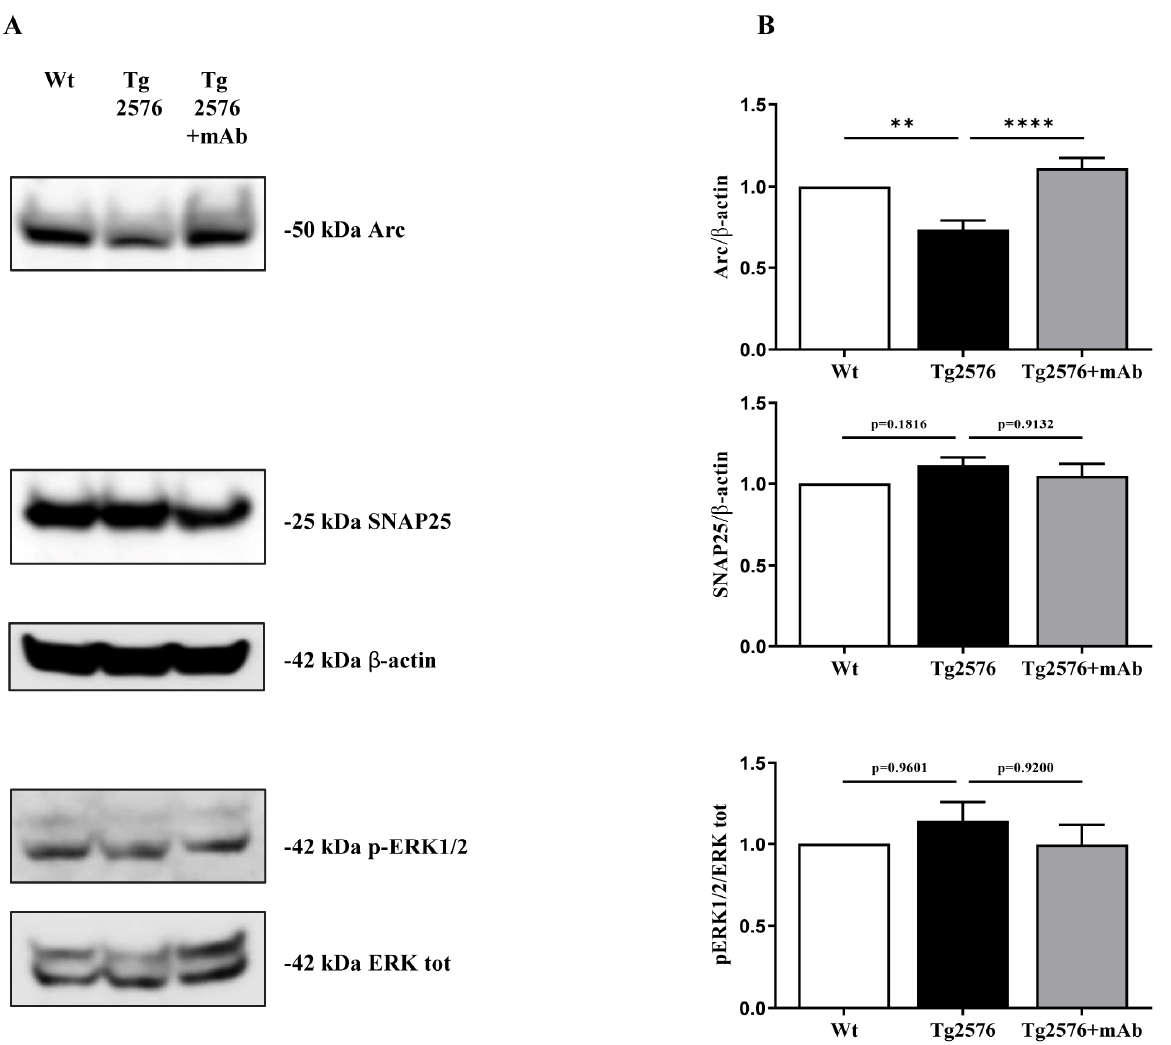
Figure 3. Effect of 12A12mAb immunization on expression pattern of experience − dependent markers of V1 plasticity from Tg2576 AD mice . ( A ) Representative images of SDS-PAGE western blotting analysis (n = 8 animals per each group, 4 males and 4 females for each experimental condition) carried out on protein homogenates of the primary visual cortex (V1) from animals of three experimental groups (littermate wild-type, vehicle-treated Tg2576, Tg2576+mAb) with antibodies reported alongside the blots. Arrows on the right side indicate the molecular weight (kDa) of bands calculated from migration of standard proteins. ( B ) Semi-quantitative densitometry of the intensity signals of bands was carried out following normalization with β -actin level used as loading control. For the determination of the phosphoERK1/2 level, the phospho-ERK 1/2/total ERK1/2 ratio was calculated. Values are from at least three independent experiments and statistically significant differences were calculated by one-way ANOVA followed by Bonferroni’s post hoc test for multiple comparisons among more than two groups. p < 0.05 was accepted as statistically significant (** p < 0.01; **** p < 0.0001).